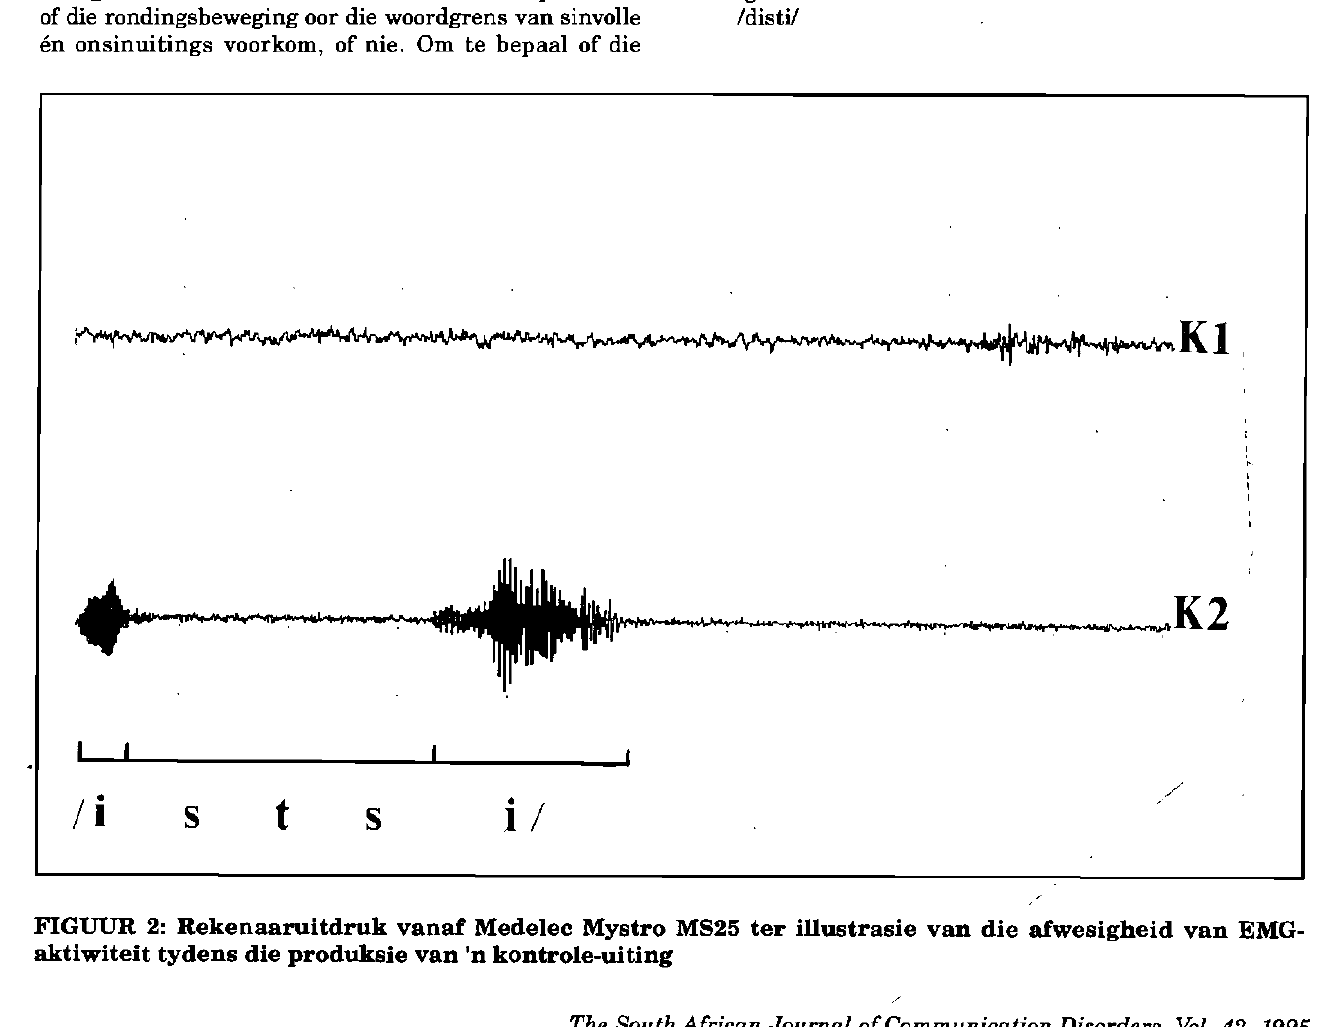
FIGUUR 2: Rekenaaruitdruk vanaf Medelec Mystro MS25 ter illustrasie van die afwesigheid van EMG- aktiwiteit tydens die produksie van 'n